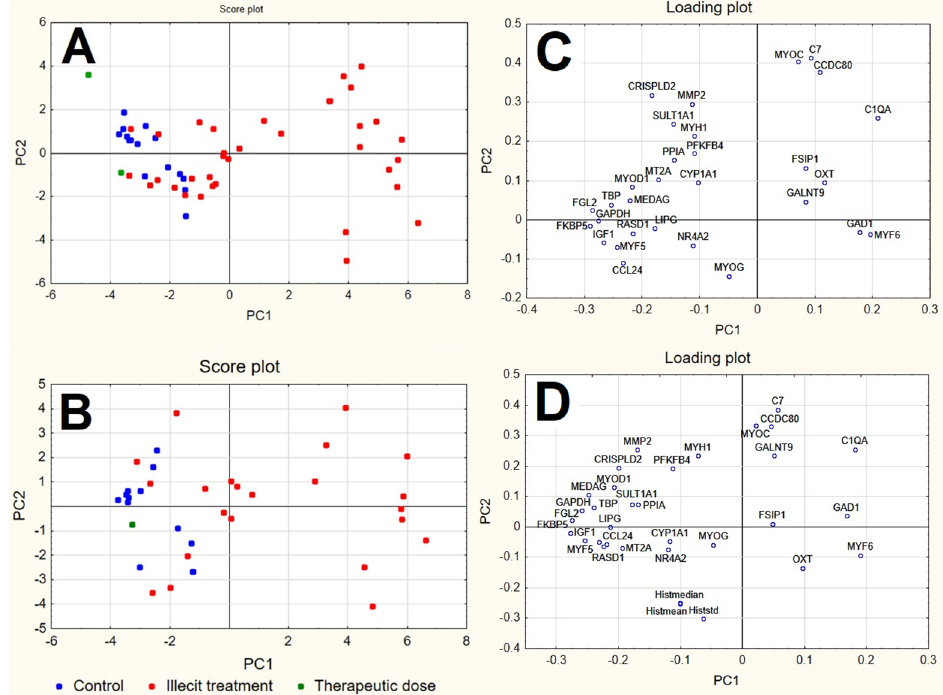
Figure 4. Score plot and loading plot of the first two PCs calculated for RQ dataset ( A , C ) and RQhisto dataset ( B , D ), after autoscaling.